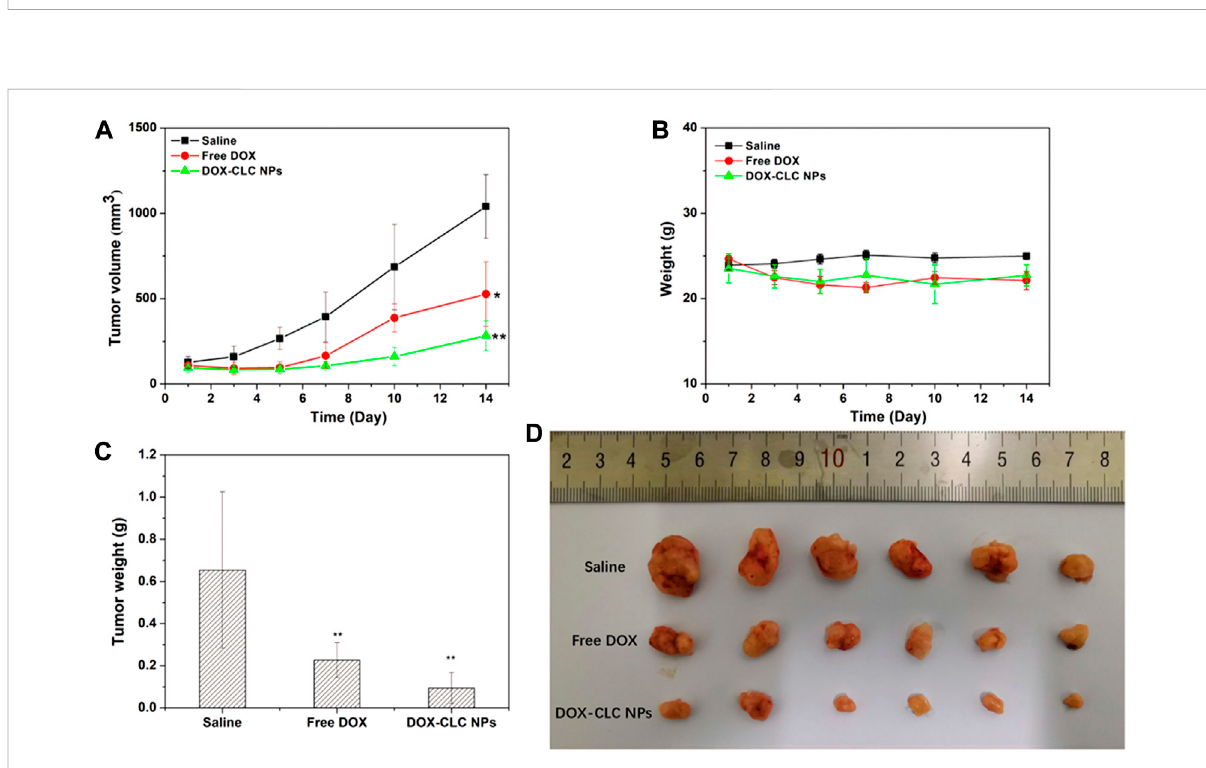
FIGURE 8 H22 tumor-bearing mice were treated with saline (control), free DOX and DOX-CLC NPs for 14 days. Tumor volume change during the treatment (A) ; Mice bodyweight change during the treatment (B) ; Tumor weight after treating with saline, free DOX and DOX-CLC NPs for 14 days (C) ; The tumor image at the end of the treatment (D) . * represents p < 0.05 versus saline; ** represents p < 0.01 versus